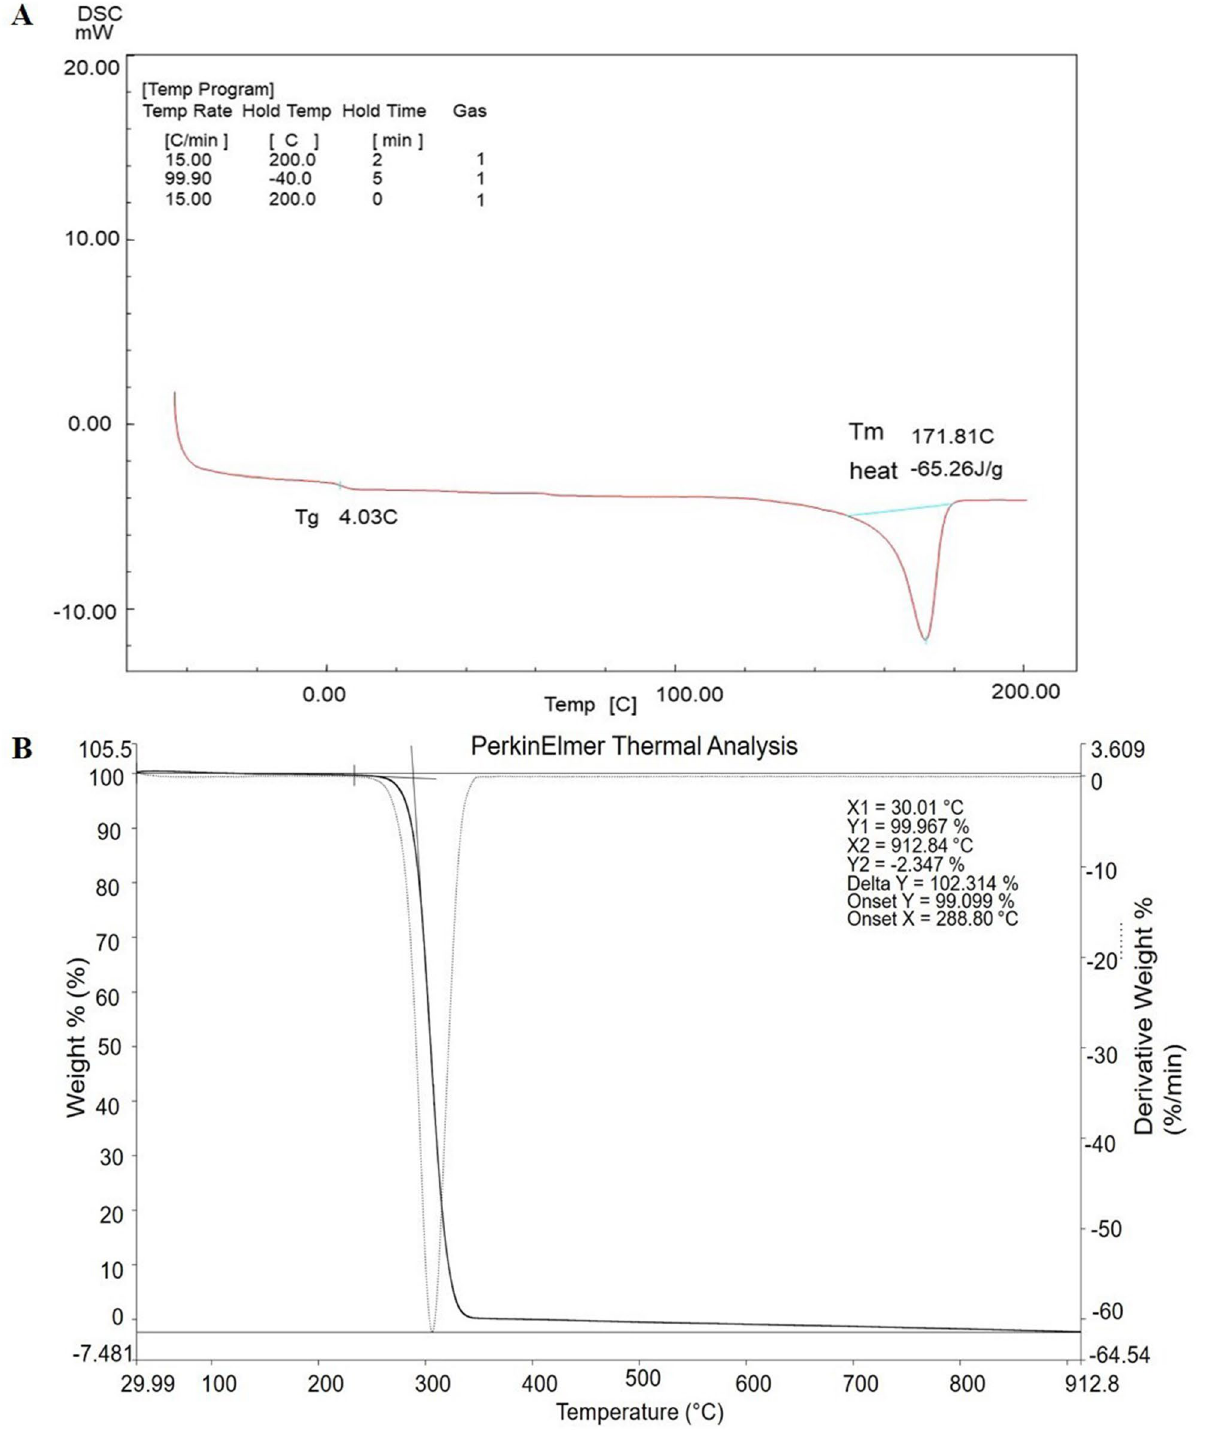
Figure 6. Differential Scanning Calorimetry (DSC) and Thermogravimetric analysis (TGA) of PHB produced by Rhodococcus pyridinivorans